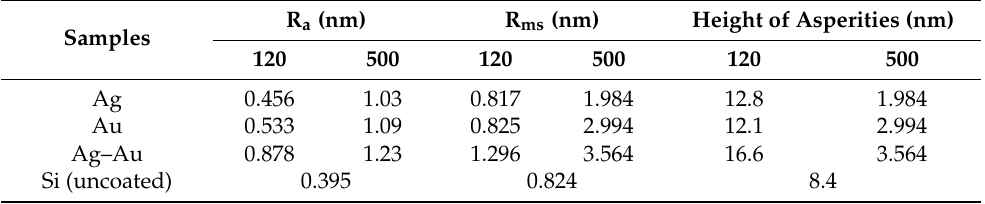
Table 2. Surface parameters of silver and gold single layers and Ag–Au compound layers.